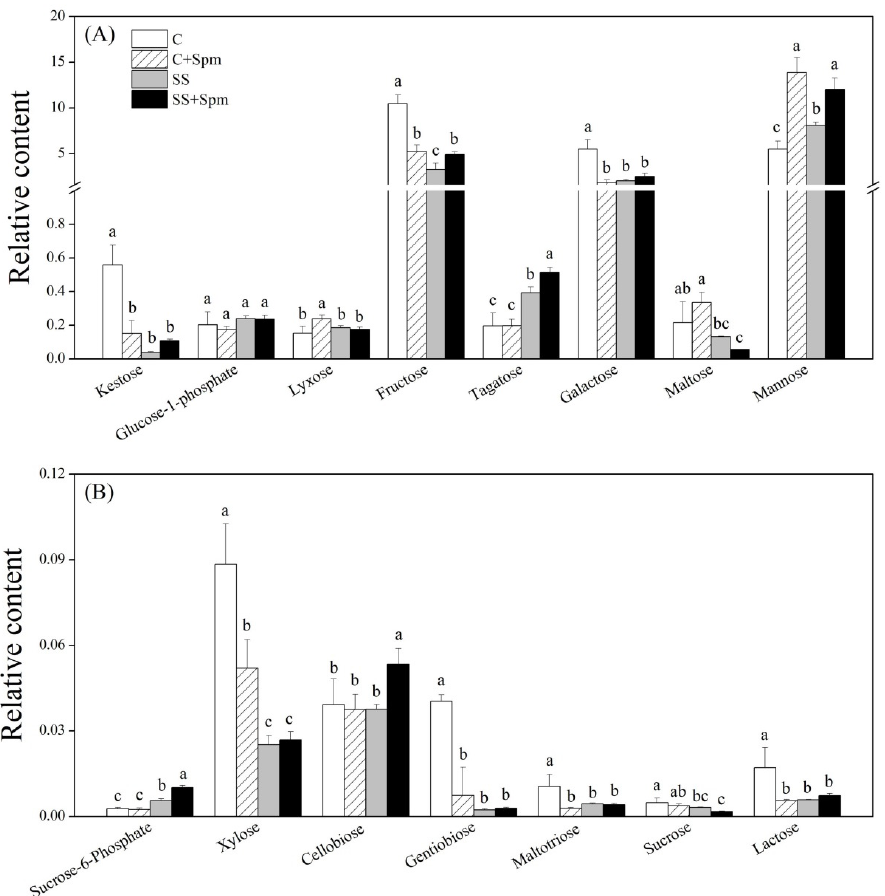
Figure 7. Effects of exogenous application of spermine (Spm) on ( A ) and ( B ) sugars under normal conditions and salt stress. Vertical bars indicate ±SE of mean (n = 4). Different letters above columns indicate significant differences based on LSD ( p < 0.05). C, control; C + Spm, control + Spm; SS, salt stress; SS + Spm, salt stress + Spm.